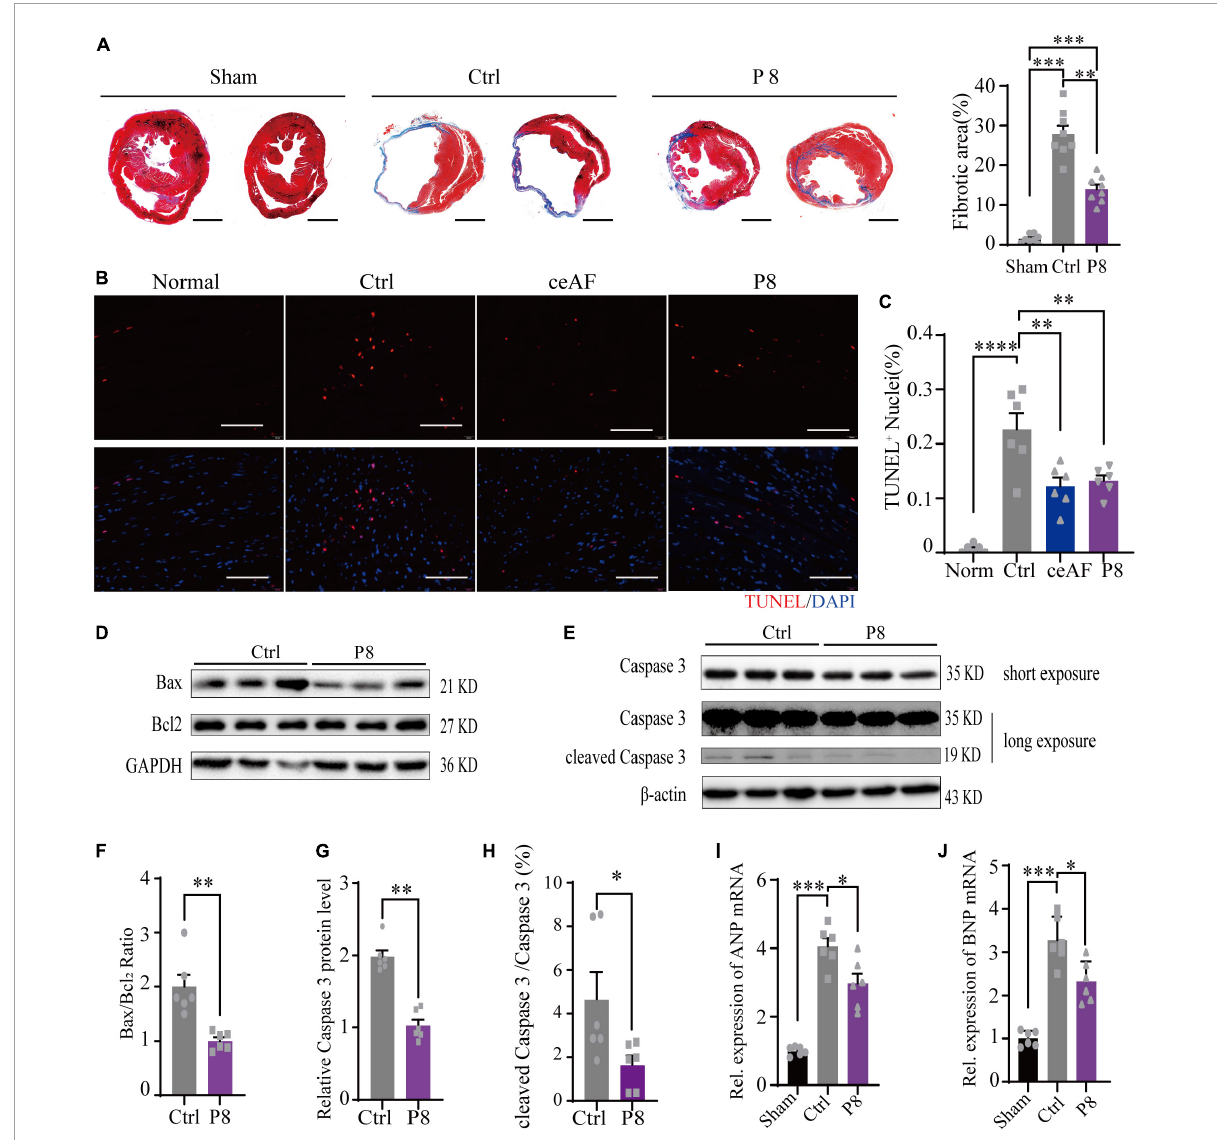
FIGURE2 P8 ameliorates myocardial injury in MI mice. (A) Representative images of heart Masson’s trichrome staining from unchallenged (sham), MI mice (control), and P8 treated MI mice (P8) (4 weeks). (Right) the statistical analysis of fibrotic area relative to myocardium in trichrome staining sections, n = 8 per group. Scale bar: 2 µ m. (B) TUNEL staining of heart tissue sections in the border zone of infarction 6 h after MI. (C) Percent of TUNEL + nuclei in mouse heart sections after 6 h with or without P8 treatment ( n = 6 per group). Scale bar: 100 µ m. (D–H) P8 decreased cardiac Bax/Bcl2, Caspase3 protein expression and cleaved Caspase 3/Caspase 3 ratio post-MI ( n = 6 per group). P8 reduced cardiac ANP (I) and BNP (J) mRNA expression post-MI ( n = 6 per group). * p < 0.05; ** p < 0.01; *** p < 0.001; **** p <